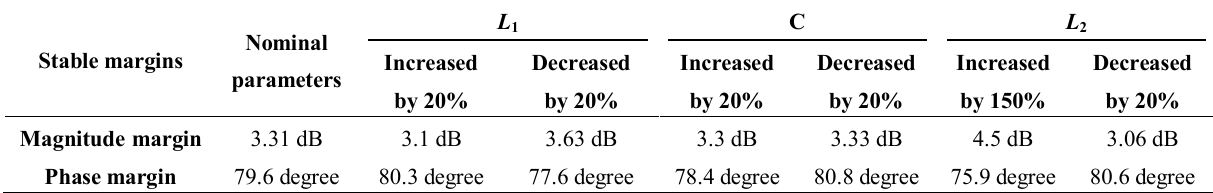
Table 2. System Magnitude and Phase margins with different